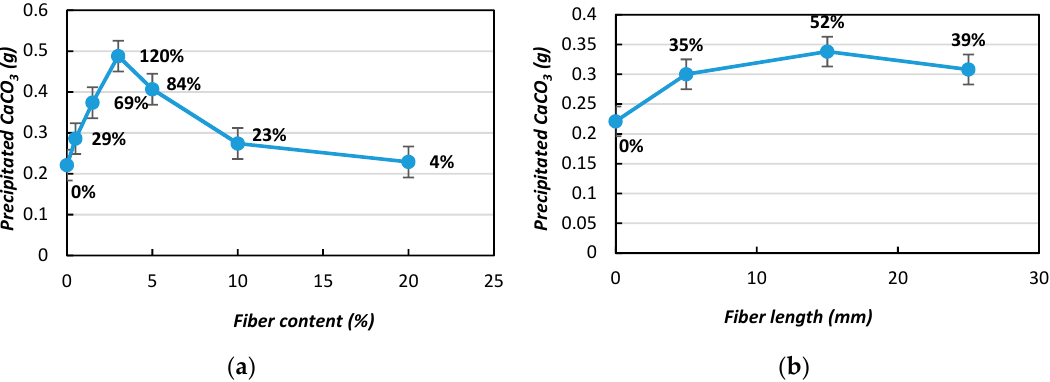
Figure 7. Effects of fiber content on CaCO 3 precipitation with the addition of jute fibers: ( a ) fiber content; ( b ) fiber length.